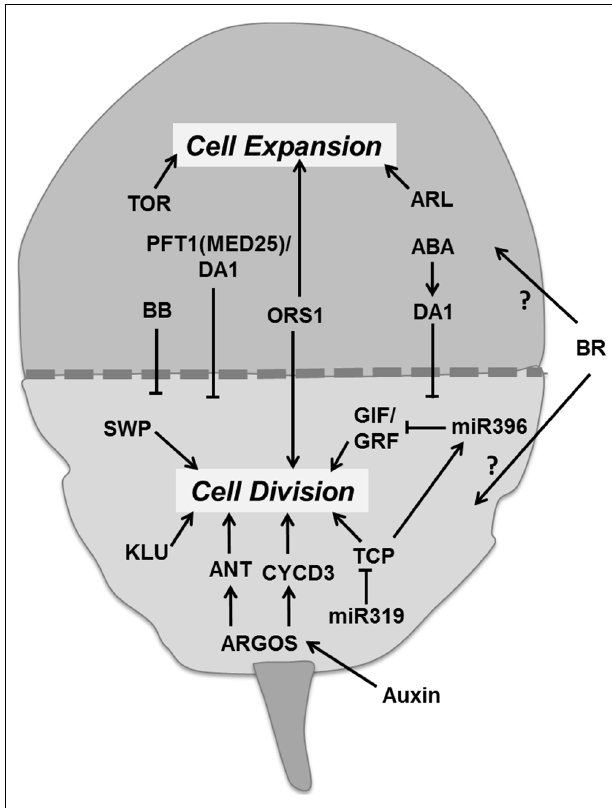
FIGURE 8 | Regulation of the transition between proliferation and cell expansion. The transition between division and expansion is shown by a dashed line which separates these two growth processes according to their regulators. ARGOS promotes cell division via DNA binding protein ANT and CYCD3 which is regulated by auxin.TCP and GIF/GRF transcription factors promote division and are negatively regulated by miRNAs. Other factors like KLU and SWP also promote proliferation. Some factors like ORS1 have a positive influence on division as well as expansion. Cell expansion is directly controlled by theTOR pathway and ARL.Whereas, other regulators like BB, MED25, and DA1 control the timing of proliferation. Abscisic acid promotes transition at least in part by regulating DA1 whereas brassinosteroids with unknown molecular mechanism (pointed andT shaped arrows indicate positive and negative regulation of the particular process and question marks show unknown mechanisms,